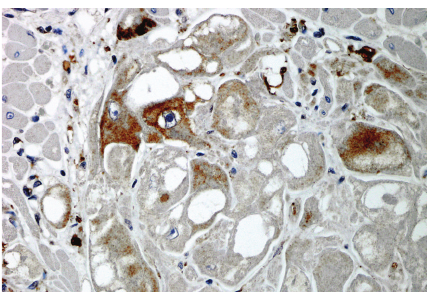
Figure 6: Heart; bearded seal. Neoplastic cells exhibit weak cyto- plasmic staining for neuron-specific